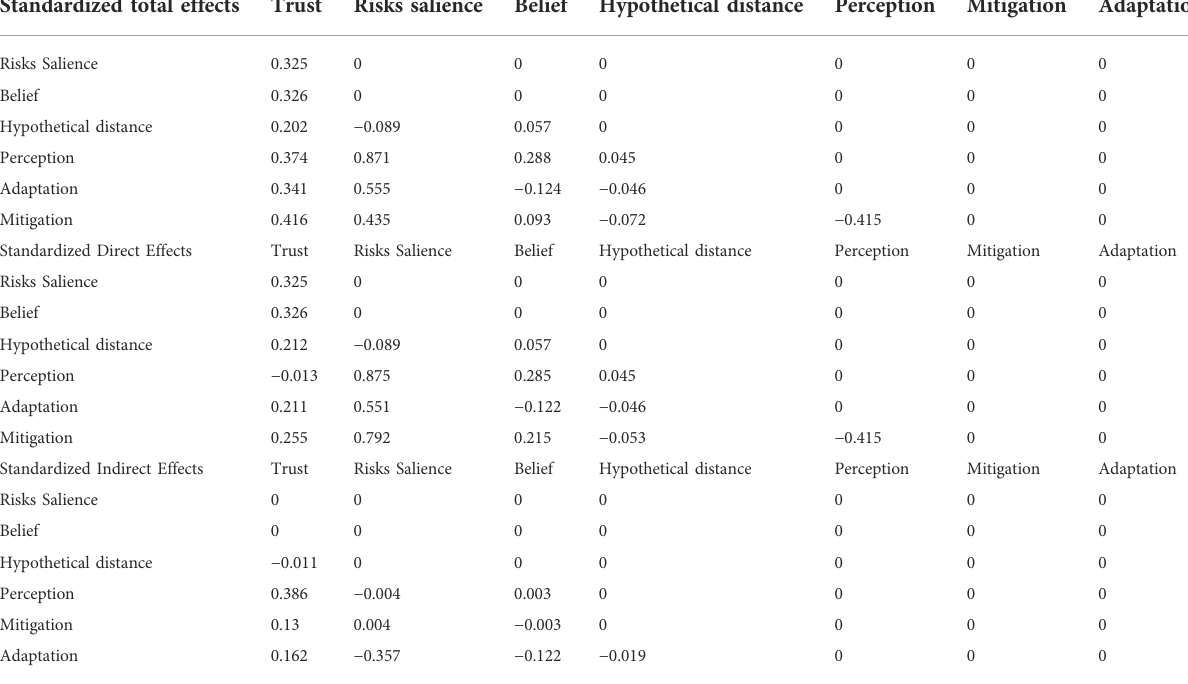
TABLE 4 The Standardized effects of the variables in Inner